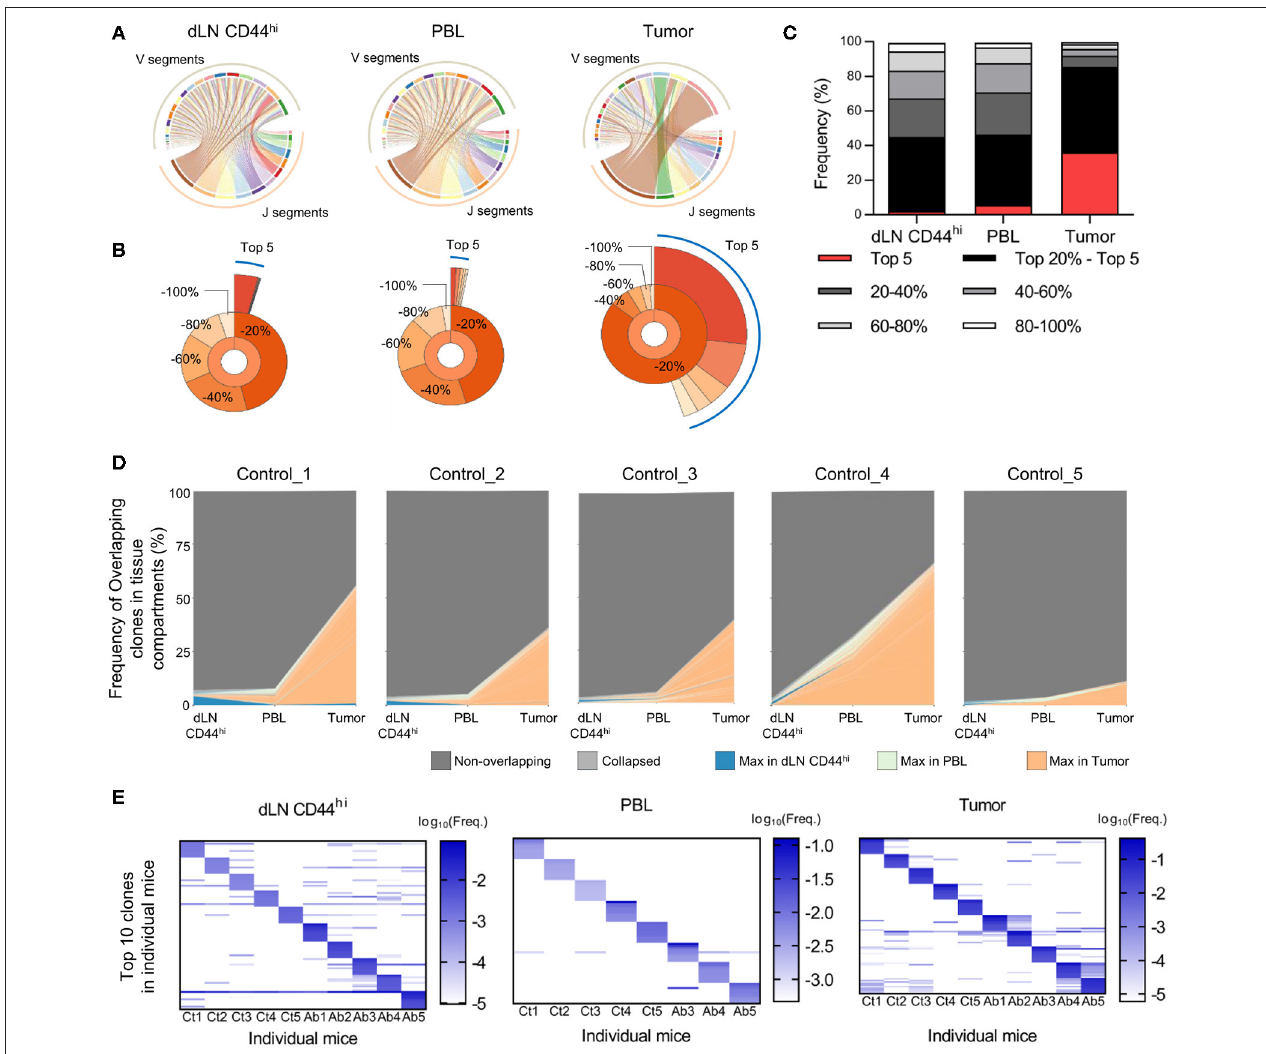
FIGURE 2 | Differences in TCR repertoires between the dLN, PBL, and tumor in tumor-bearing mice. Mice bearing B16F10 tumors were analyzed on day 14 after tumor inoculation. (A) V/J segment usage plots of the dLN CD44 hi , PBL, and tumor repertoires of a control mouse. Ribbons connecting the V and J segments are scaled by the corresponding V/J pair frequency. (B) Quantile statistics of the dLN CD44 hi , PBL, and tumor in a control mouse. The second layer of the pie chart displays the combined frequency of the top 20, 20–40, 40–60, 60–80, and 80–100% clones. The third layer displays the individual frequency of the top 5 clones. (A,B) are figures depicting data from the same mouse. (C) Average of quantile statistics in control mice ( n = 5). (D) IOCT analysis in individual control mice. The top 100 overlapping clones in at least two compartments are colored by the tissue compartment in which their frequency was the highest, whereas the clones whose frequencies were below the top 100 are shown as light gray and labeled “Collapsed” in the figure legend. (E) Variability of TCR repertoire between individual mice in the dLN CD44 hi , PBL, and tumor. The top 10 clones of individual mice were plotted on the heat map. Each column and row represent the individual mice and clones, respectively. Colors represent the log 10 scaled frequency of clones in each mouse as indicated by a color scale. Undetected clones are colored white. (A–C) present the data of control group. In (E) T cell clones were determined as the TCR reads with the same TCR V segment, J segment, and CDR3 amino acid sequence. All figures present the data for TCR β